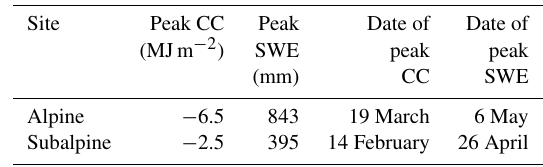
Table 1. Mean quantities for the alpine and subalpine snow pits from WY2007 to WY2013.